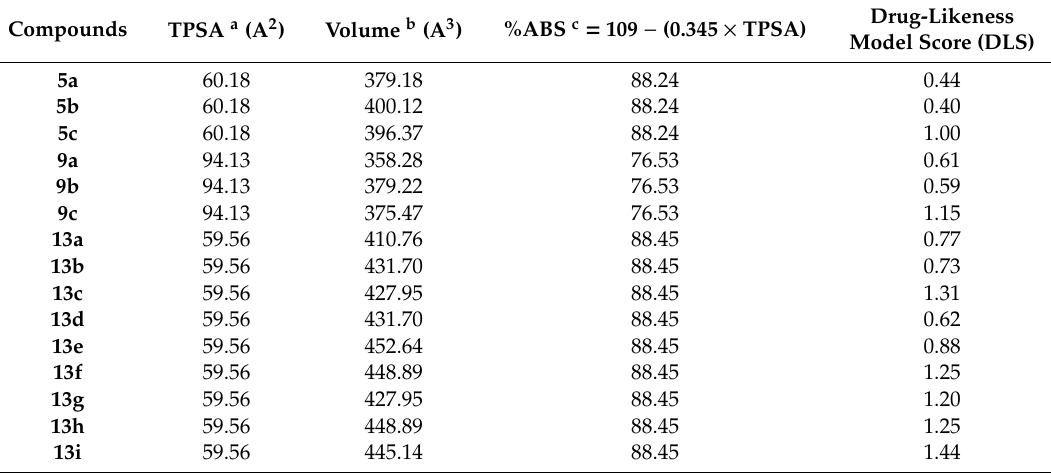
Table 5. Drug likeness calculations of the compounds pyrazolo[1,5- a ]pyrimidines 5a – c, 9a – c and 13a – i.